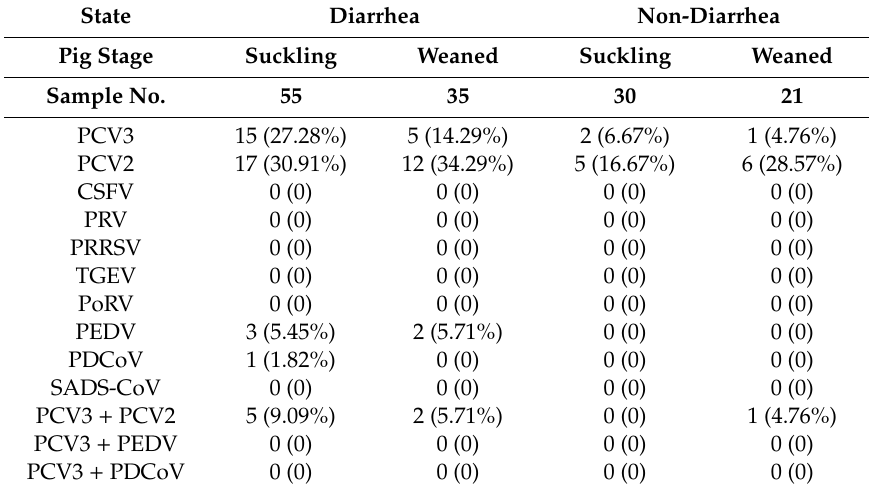
Table 1. Detection results of Porcine circovirus 3 (PCV3) and other associated viruses in pigs with diarrhea and